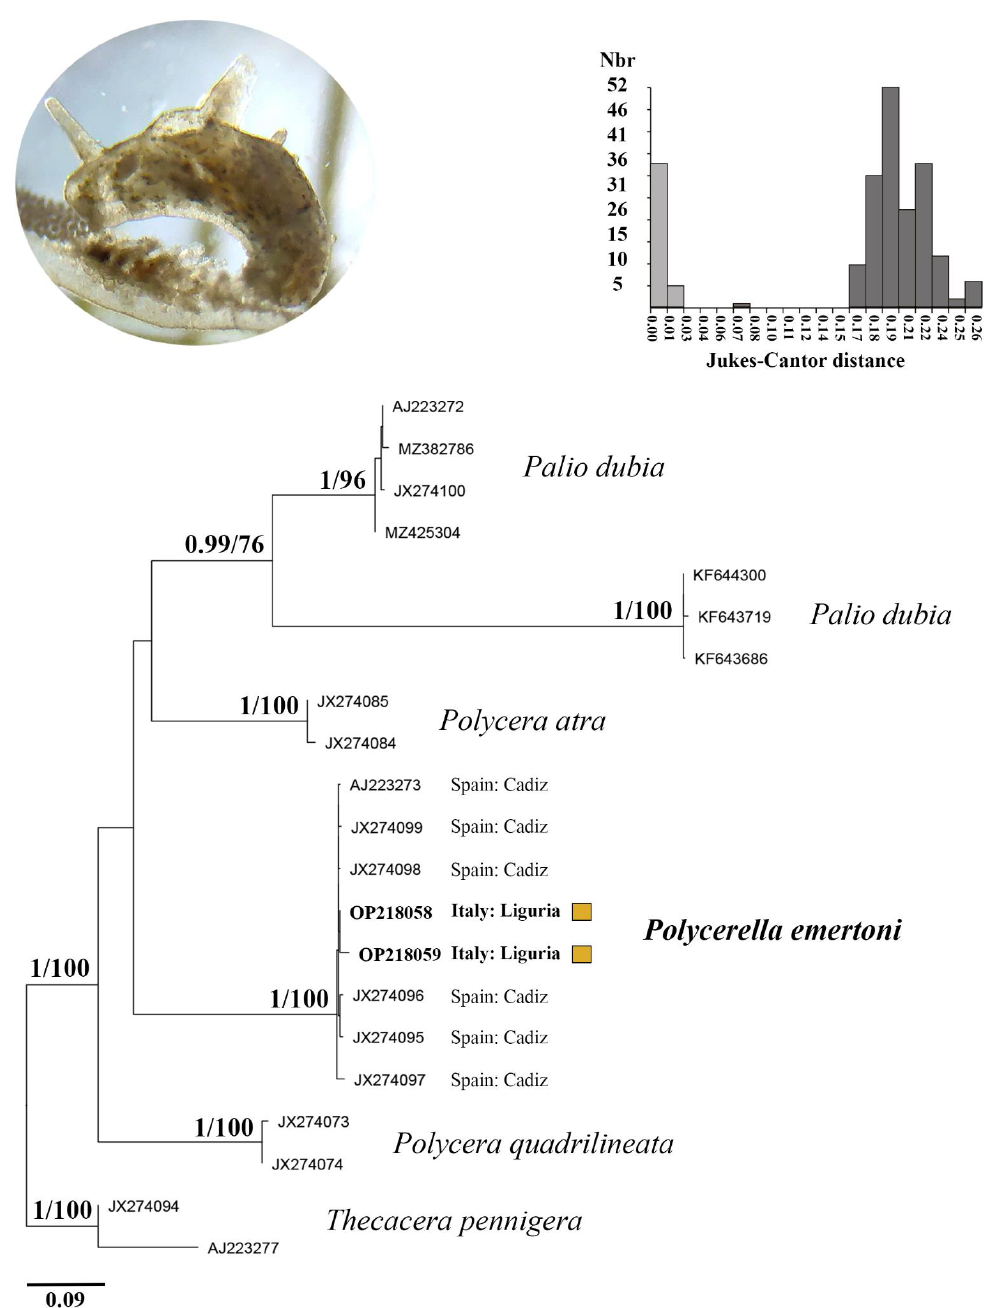
Figure 4. Maximum likelihood topology based on the COI dataset with results from species delimita- tion analyses (right, top). Numbers at nodes indicate Bayesian posterior probability (BPP; left) of the BI and bootstrap support (BP; right) from the ML. BPP < 0.50 and BP < 50% were not reported. The histogram in the upper right part shows the distribution of the pairwise genetic distances (JC69) in intraspecific (left, light grey) and interspecific (right, dark grey) comparisons. The orange-colored quadrants highlight P. emertoni Ligurian